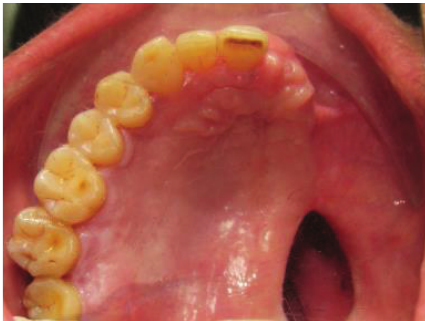
Figure 4: Master cast of defect